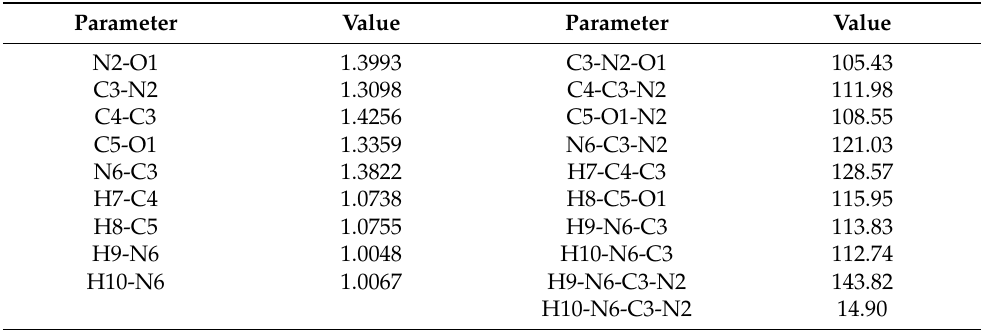
Table 1. Geometry of 3-aminoisoxazole optimized at the junChS level. Distances in Å and angles in